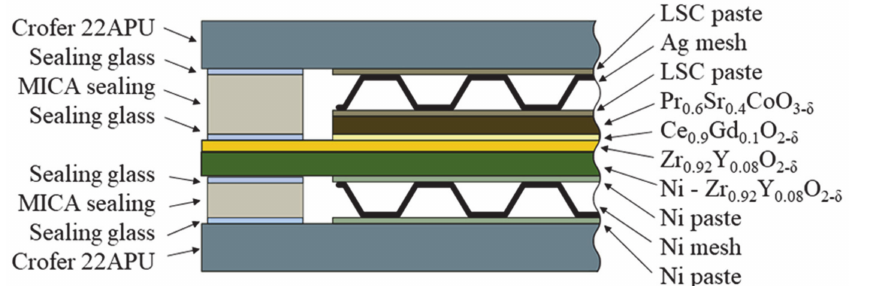
Figure 2. Schematic drawing of the membrane electrode assembly for electrochemical